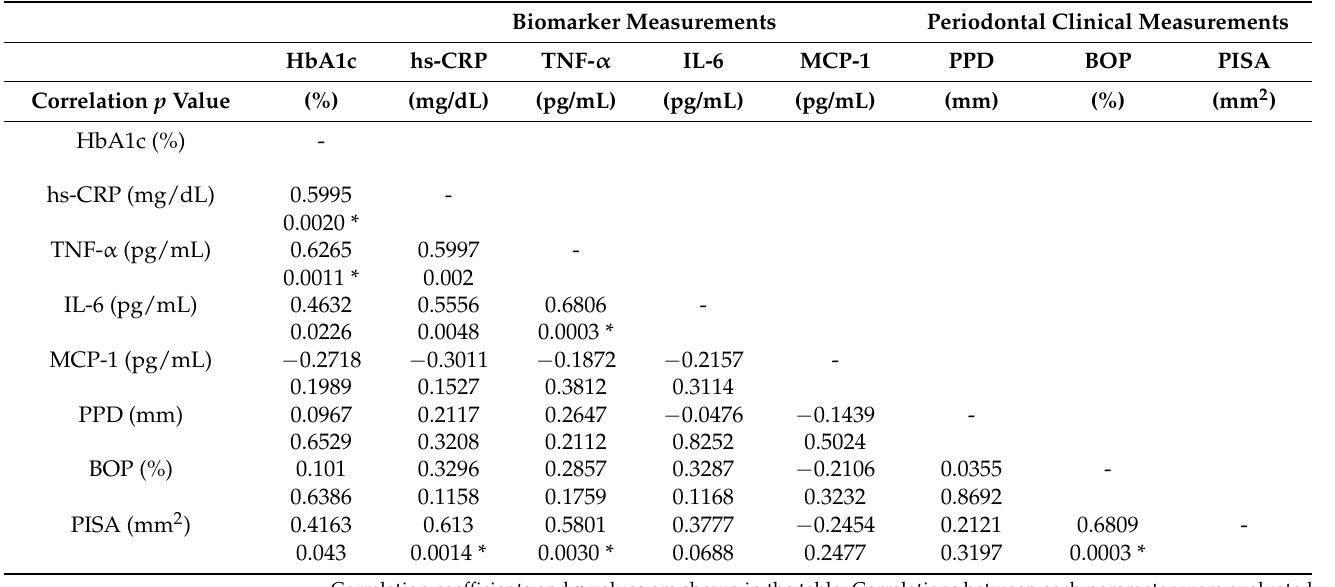
Table 6. Correlations between changes in HbA1c, inflammatory markers, and clinical parameters during nine months in the FM-SRP group.